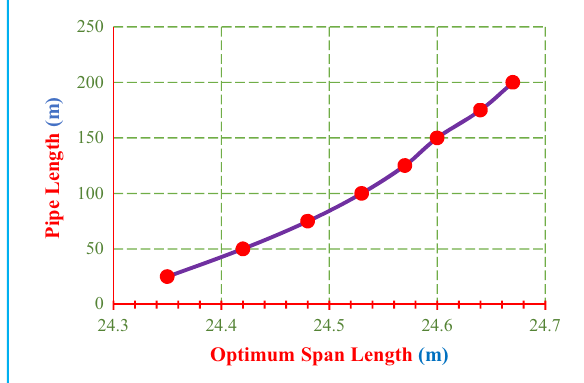
Figure 4: Optimum span length vs discharge.